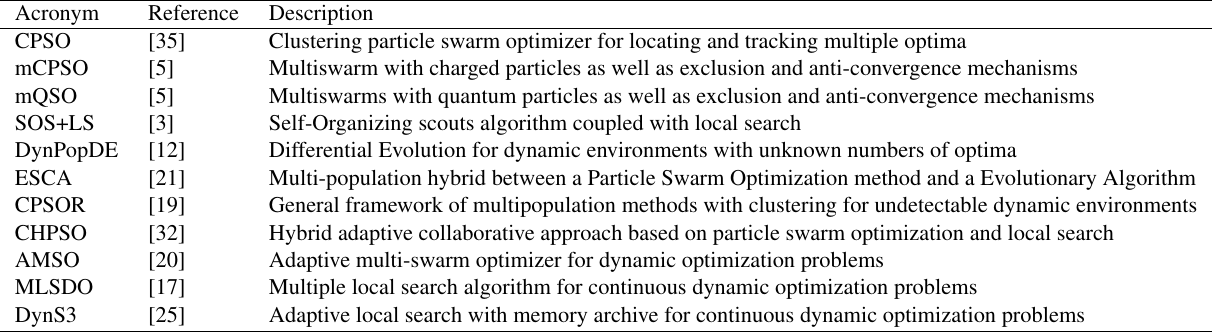
Table 7. Acronym, bibliographic reference and description of the state-of-the-art algorithms consid- ered in the